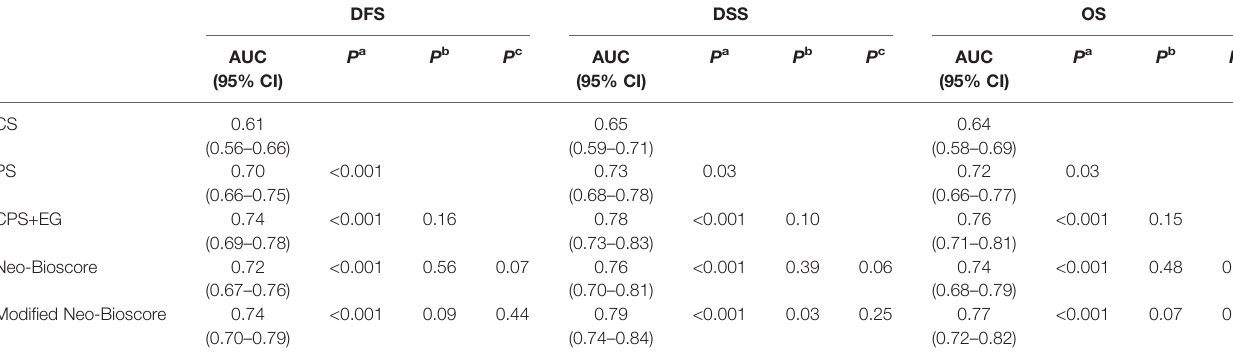
CS, pretreatment clinical stage; PS, post-treatment pathological stage; CPS+EG, clinical-pathologic stagingsystem incorporating estrogen receptor-negativedisease andnuclear grade 3 tumor pathology; AUC, area under the curve; DFS, disease free survival; DSS, disease speci fi c survival; OS overall survival. a Contrast estimate with CS as reference; b Contrast estimate with PS as reference; c Contrast estimate with CPS + EG as